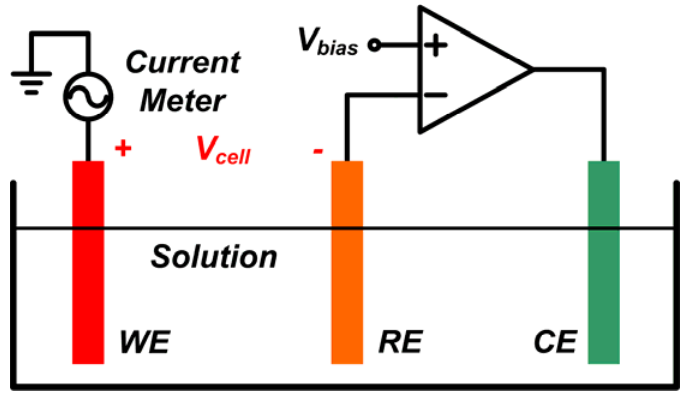
Figure 1. Conceptual drawing of three electrode amperometric electrochemical sensor and